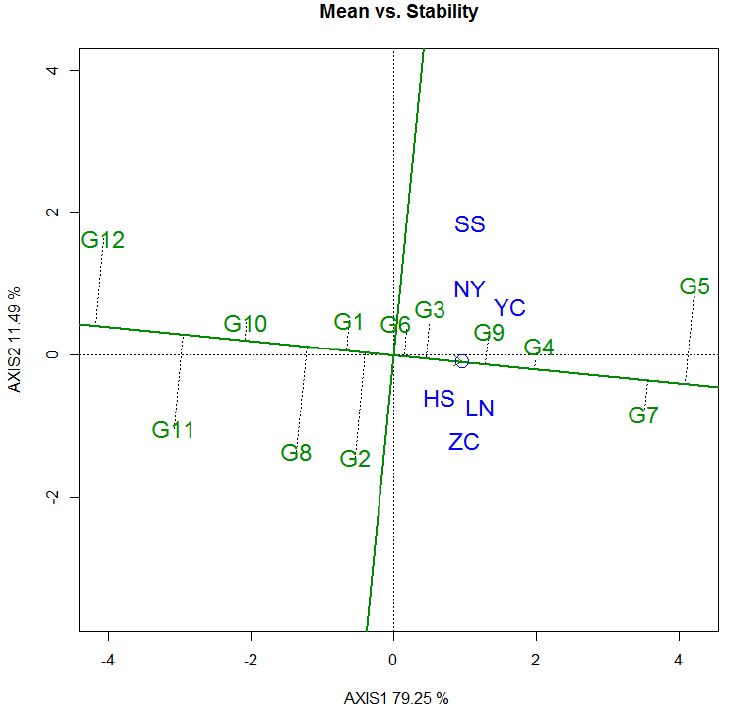
Figure 7. DBH mean and stability of 12 genotypes. The small blue circle on the horizontal axis represents the average environmental yield. The yield of genotype traits increases along the horizontal axis, and the stability decreases with the increase in the vertical distance.